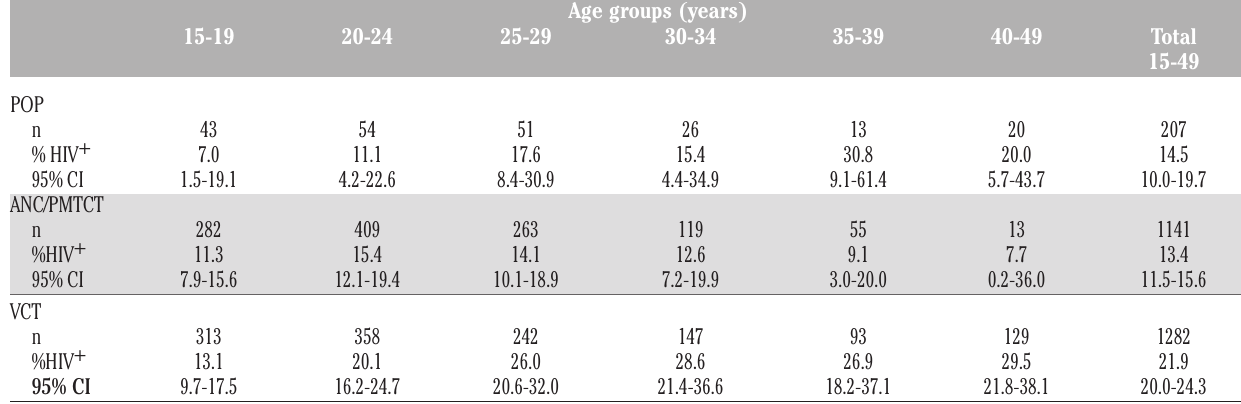
Figure 1. Perceived rea- sons for high HIV prevalence in Fort-Portal municipality (n=360). n, number of respondents who said “yes” per